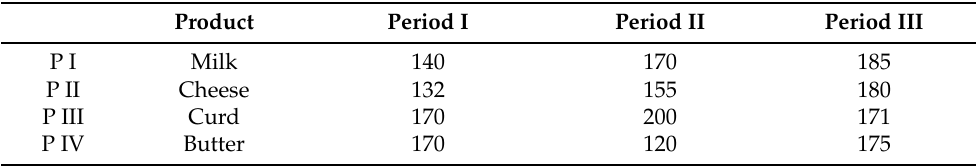
Table A11. Consumption at destination/retailers.